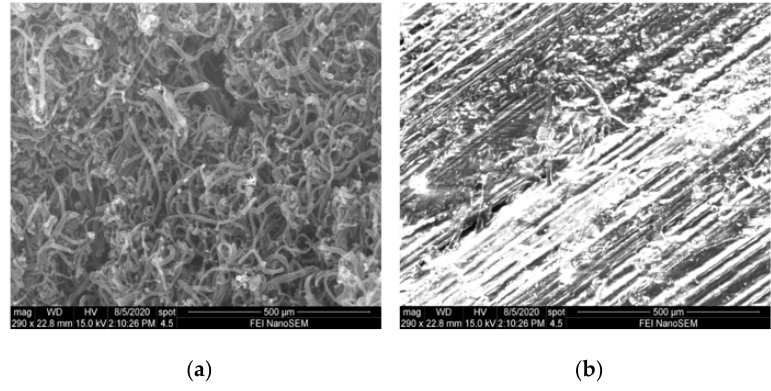
Figure 10. ( a ) SWCNT forest and ( b ) aligned SWCNT on prepreg glass fibers.